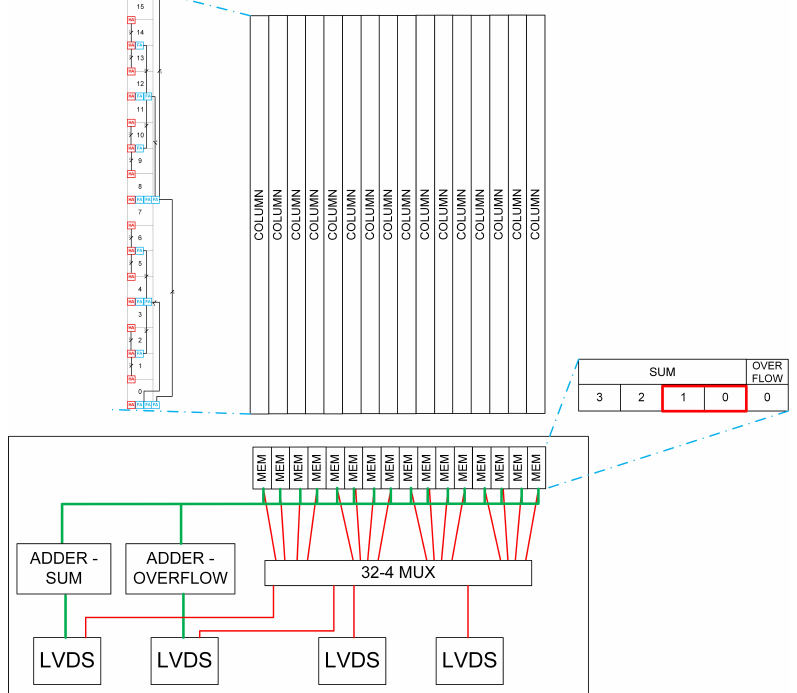
Figure 13. Outline of how the peripheral logic of the chip functions. The zoomed section indicates where the column from Figure 11 fits in. The green path represents “pad” mode, and the red path “column” mode.